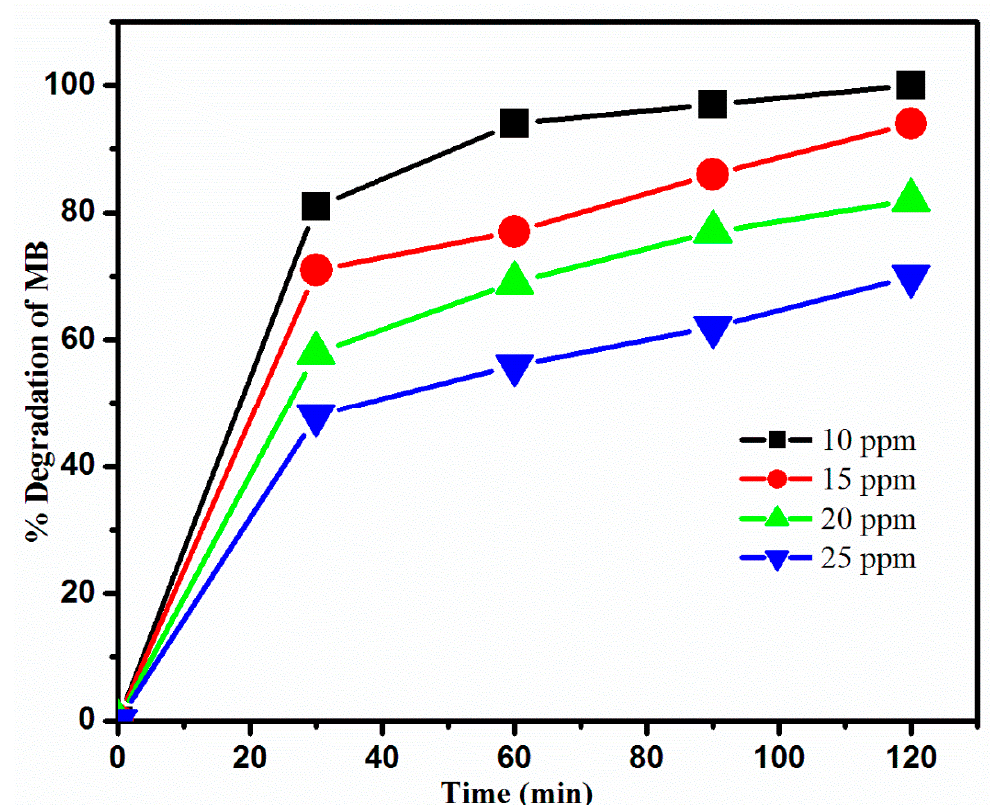
Figure 17. Percentage photodegradation of MB at varying concentrations of dye with respect to time.